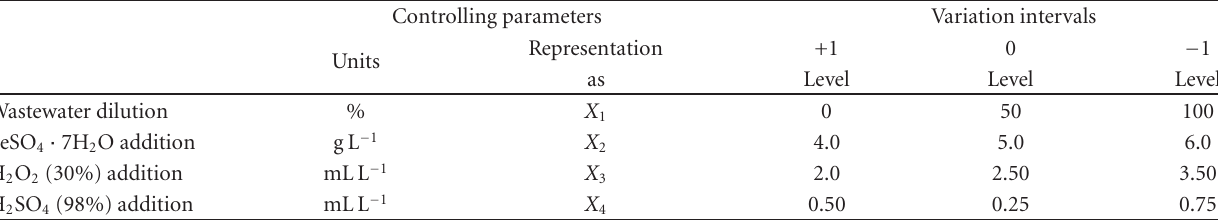
Table 1: Controlling parameters and their levels in the factorial experiment.